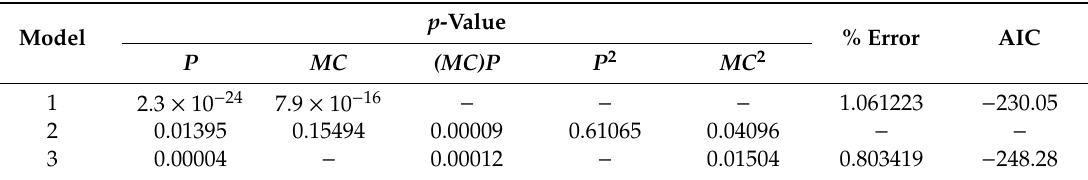
Table A1. Results for model